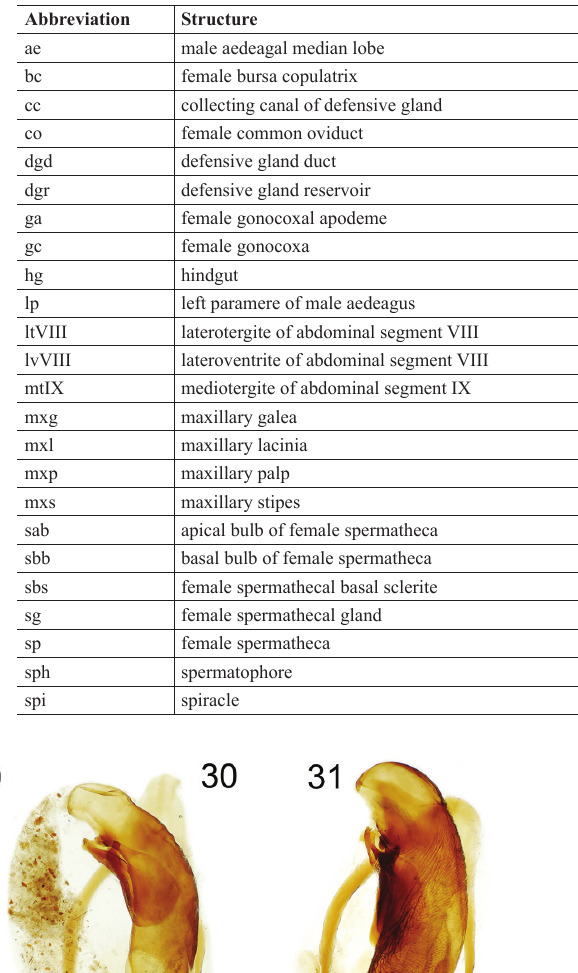
Table 1. Key to abbreviations for morphological structures in- dicated in